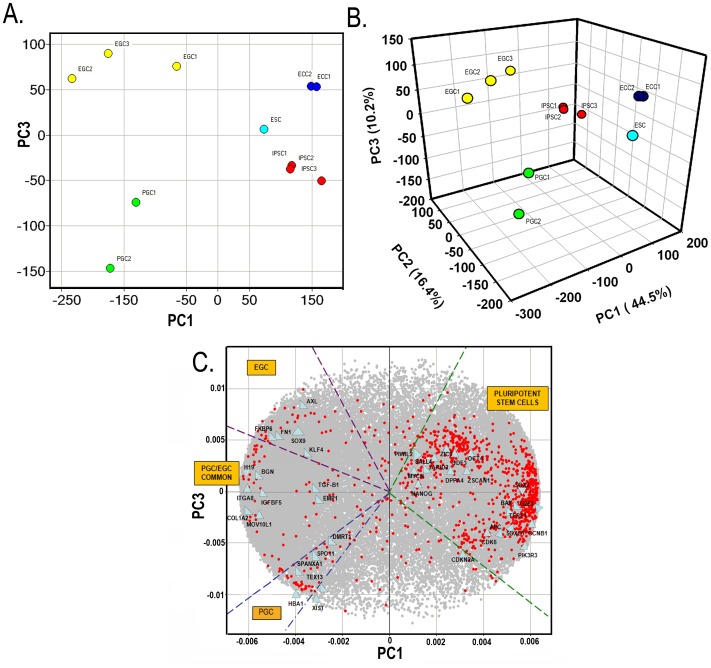
Principal component analysis (PCA) of the expression profiles of primordial germ cells and pluripotent stem cells.(A) Two-dimensional PCA map of cell types, comparing PC1 and PC3. (B) Three-dimensional map comparing all cell types. (C) A loading scatter plot for the identification of signature genes. Red dots represent the top 1000 differentially genes expressed across the mean of all lines with FDR adjusted P<0.0001. “PGC signature” genes include HBA1, TEX13, and SPO11 located on the lower left half of the scatter plot. In contrast, XIST was upregulated in PGCs compared to other pluripotent stem cell lines as expected given their differentiated state. “PGC/EGC common” genes include H19, BGN, ITGA8, IGFB5, MOV10L1, and TGF-B1. “EGC signature” genes include SOX9, KLF4, FN1, AXL, and FKBP6. “ECC, ESC, and IPSC” signature genes include DPPA4, NANOG, SOX2, PIWIL2, MYCN, GDF3, and OCT4.